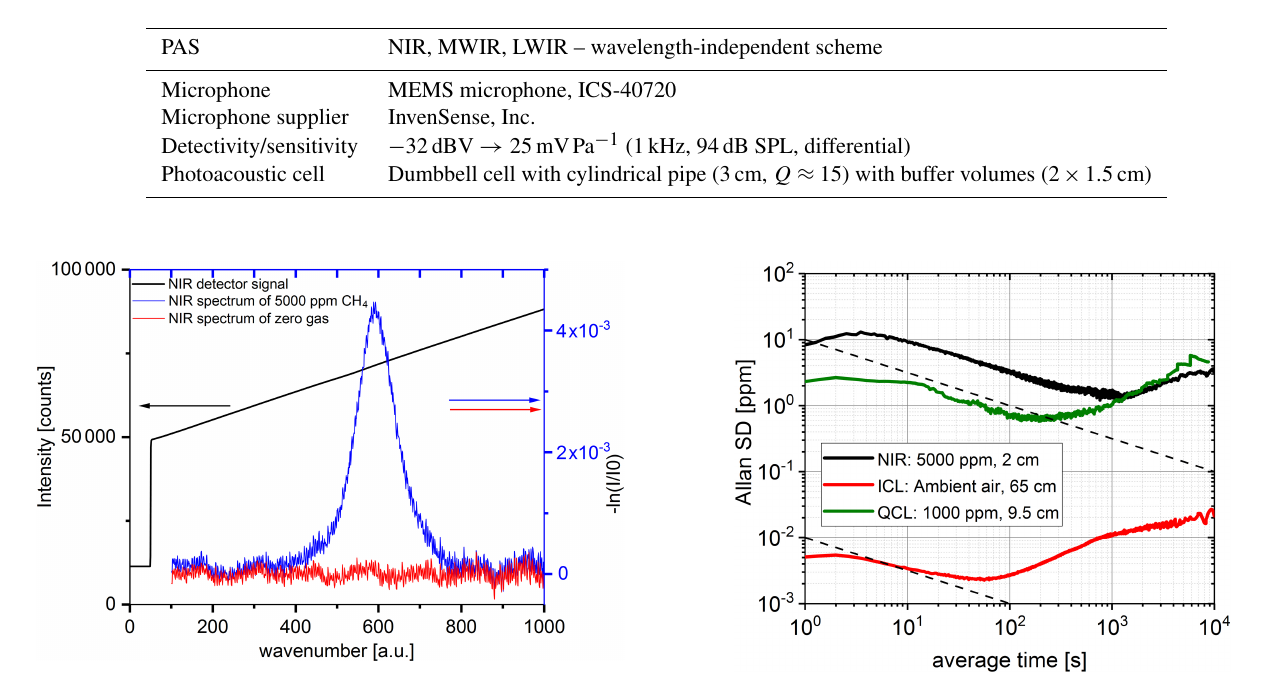
Table 3. Microphone and cell properties for the PAS experiments.